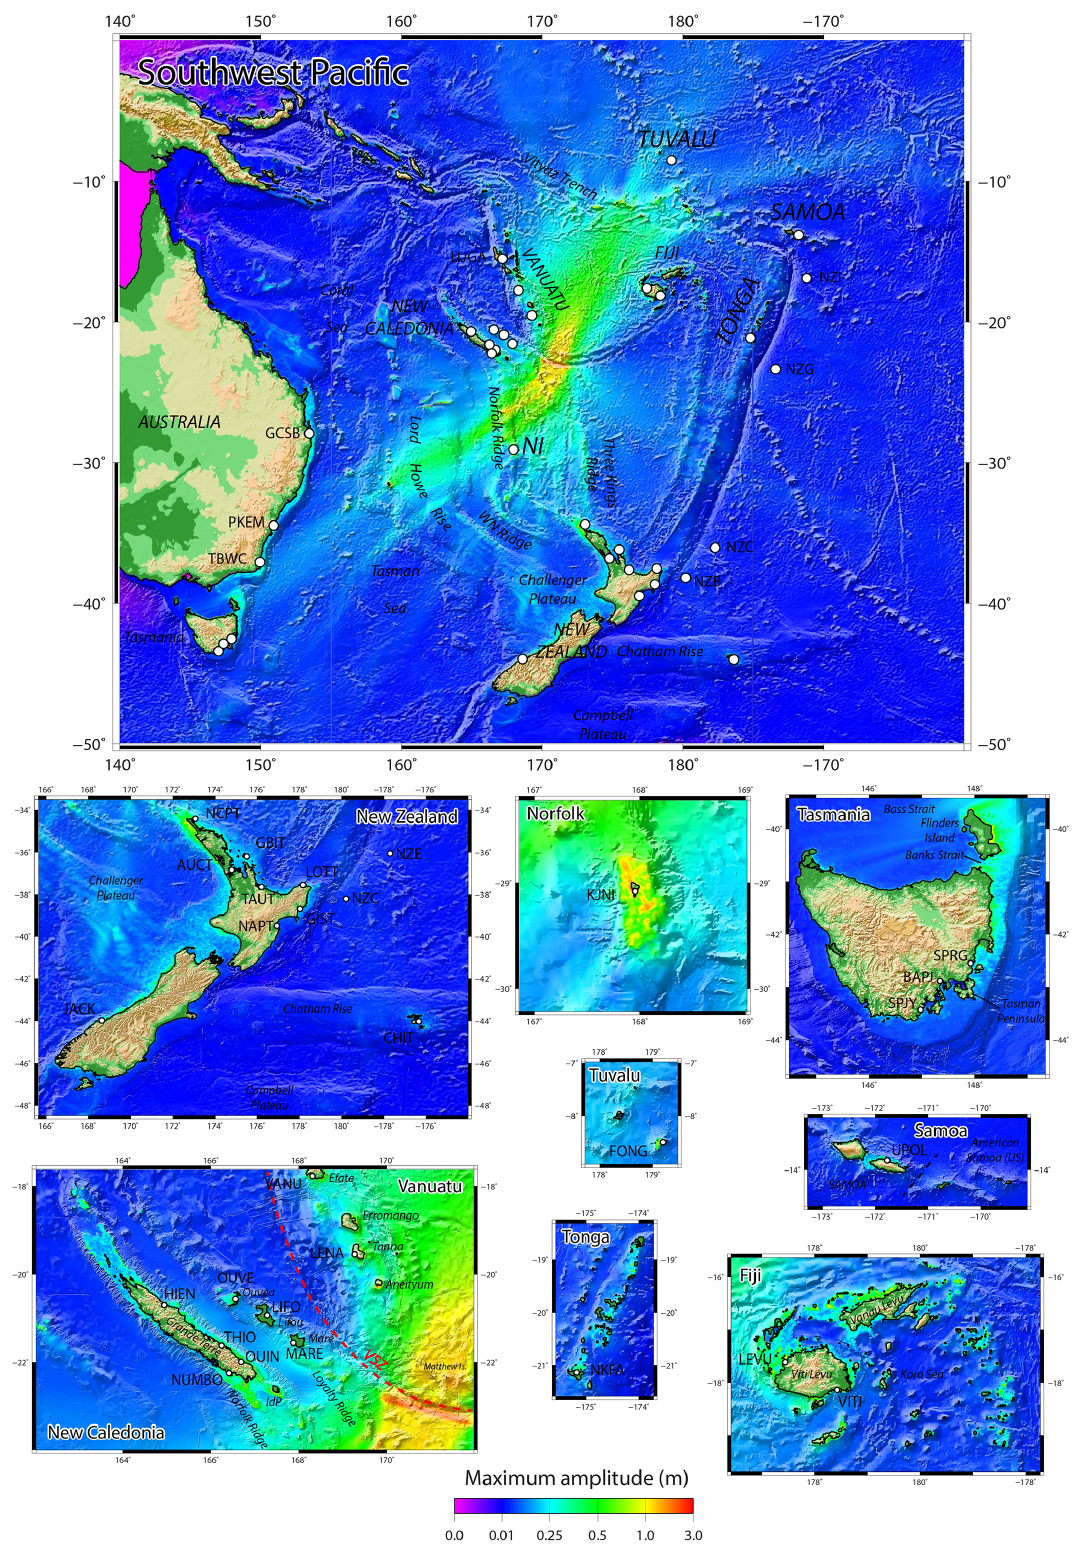
Figure 12. Maximum wave amplitude maps obtained after 12h of simulated tsunami propagation for a plausible M w 8.2 rupture scenario with uniform slip proposed in this study. The white circles locate the coastal gauges and DART stations used in this study. IdP: Isle of Pines, NI: Norfolk Island, NW Ridge: West Norfolk Ridge, VSZ: Vanuatu subduction zone (red dashed line). https://doi.org/10.5194/nhess-23-393-2023 Nat. Hazards Earth Syst. Sci., 23, 393–414,